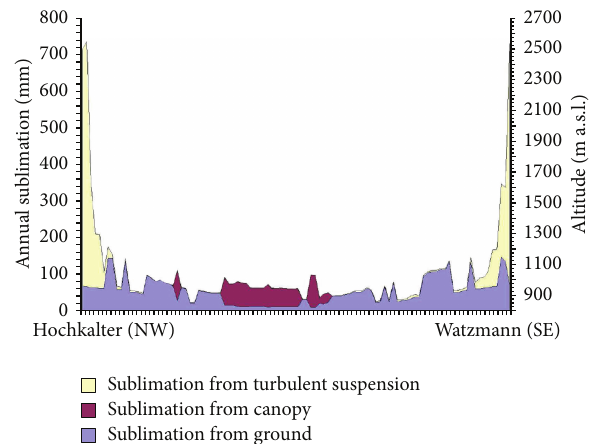
Figure 1: Reproduced from Strasser et al. [8], simulated contribu- tions to total annual snow sublimation from ground sublimation, canopy sublimation, and blowing snow sublimation along a ∼ 4 km transect across Wimbach valley in Berchtesgaden National Park,